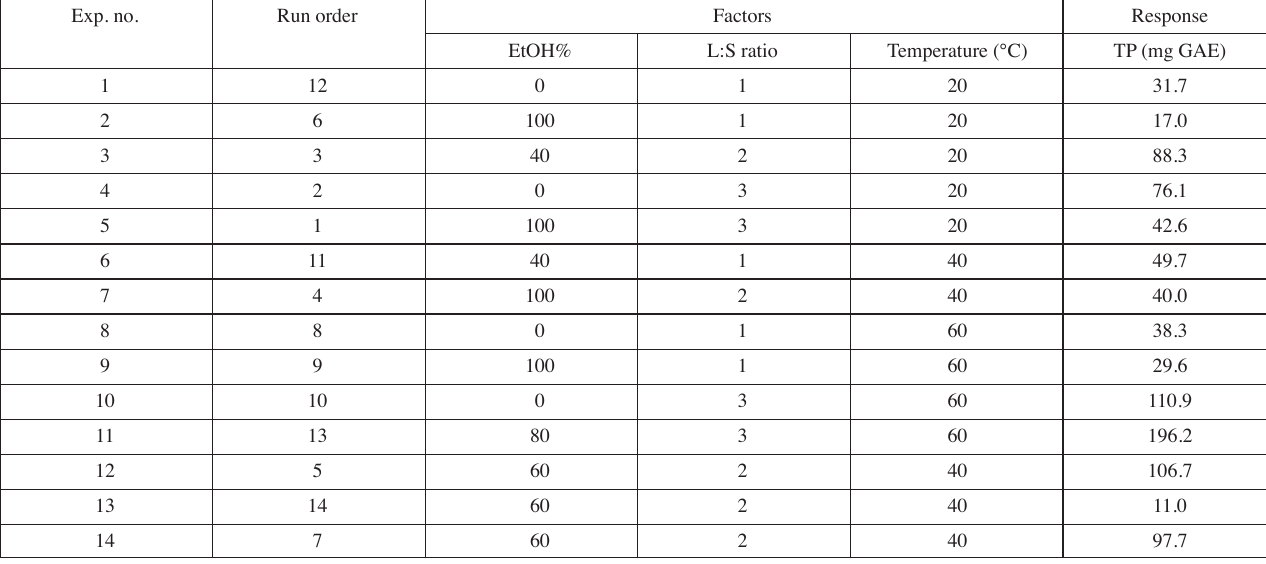
Tab. 1: Worksheet and response for D-optimal design Exp.